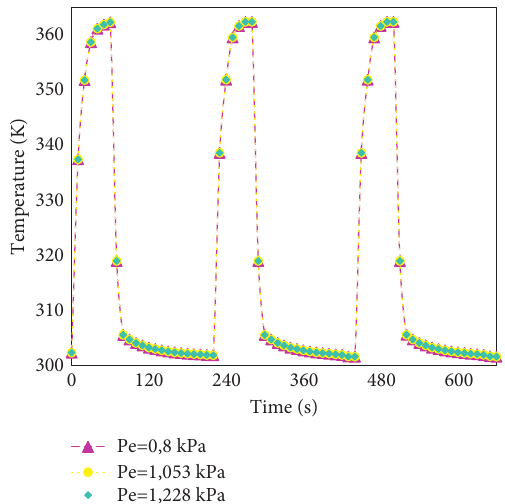
Figure 6: Variation of average bed temperature with time for different P